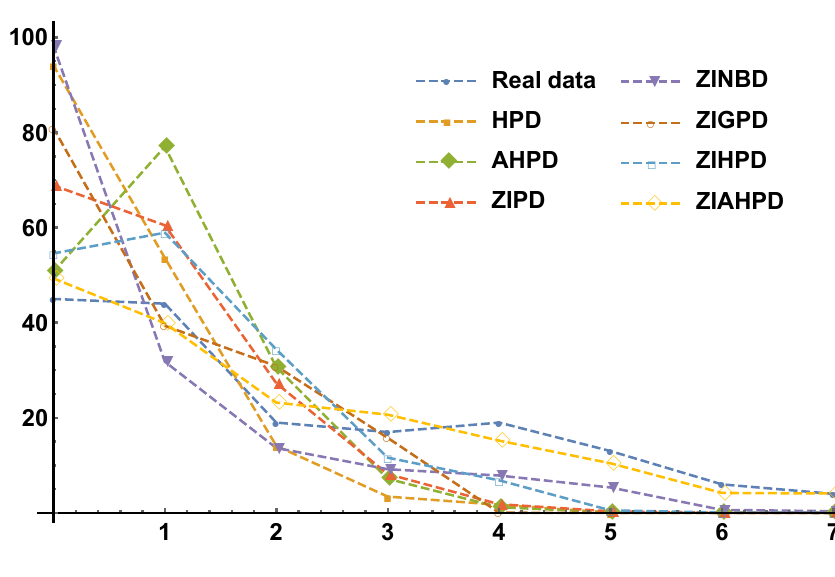
Figure 10 – Frequency curves corresponding to data set 2